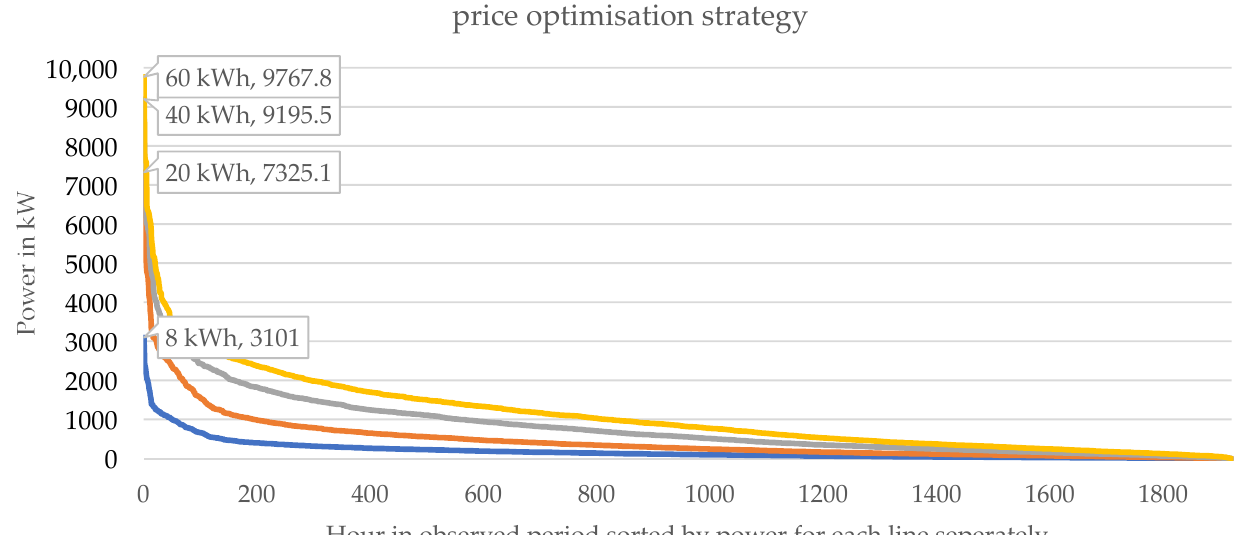
Hour in observed period sorted by power for each line seperately